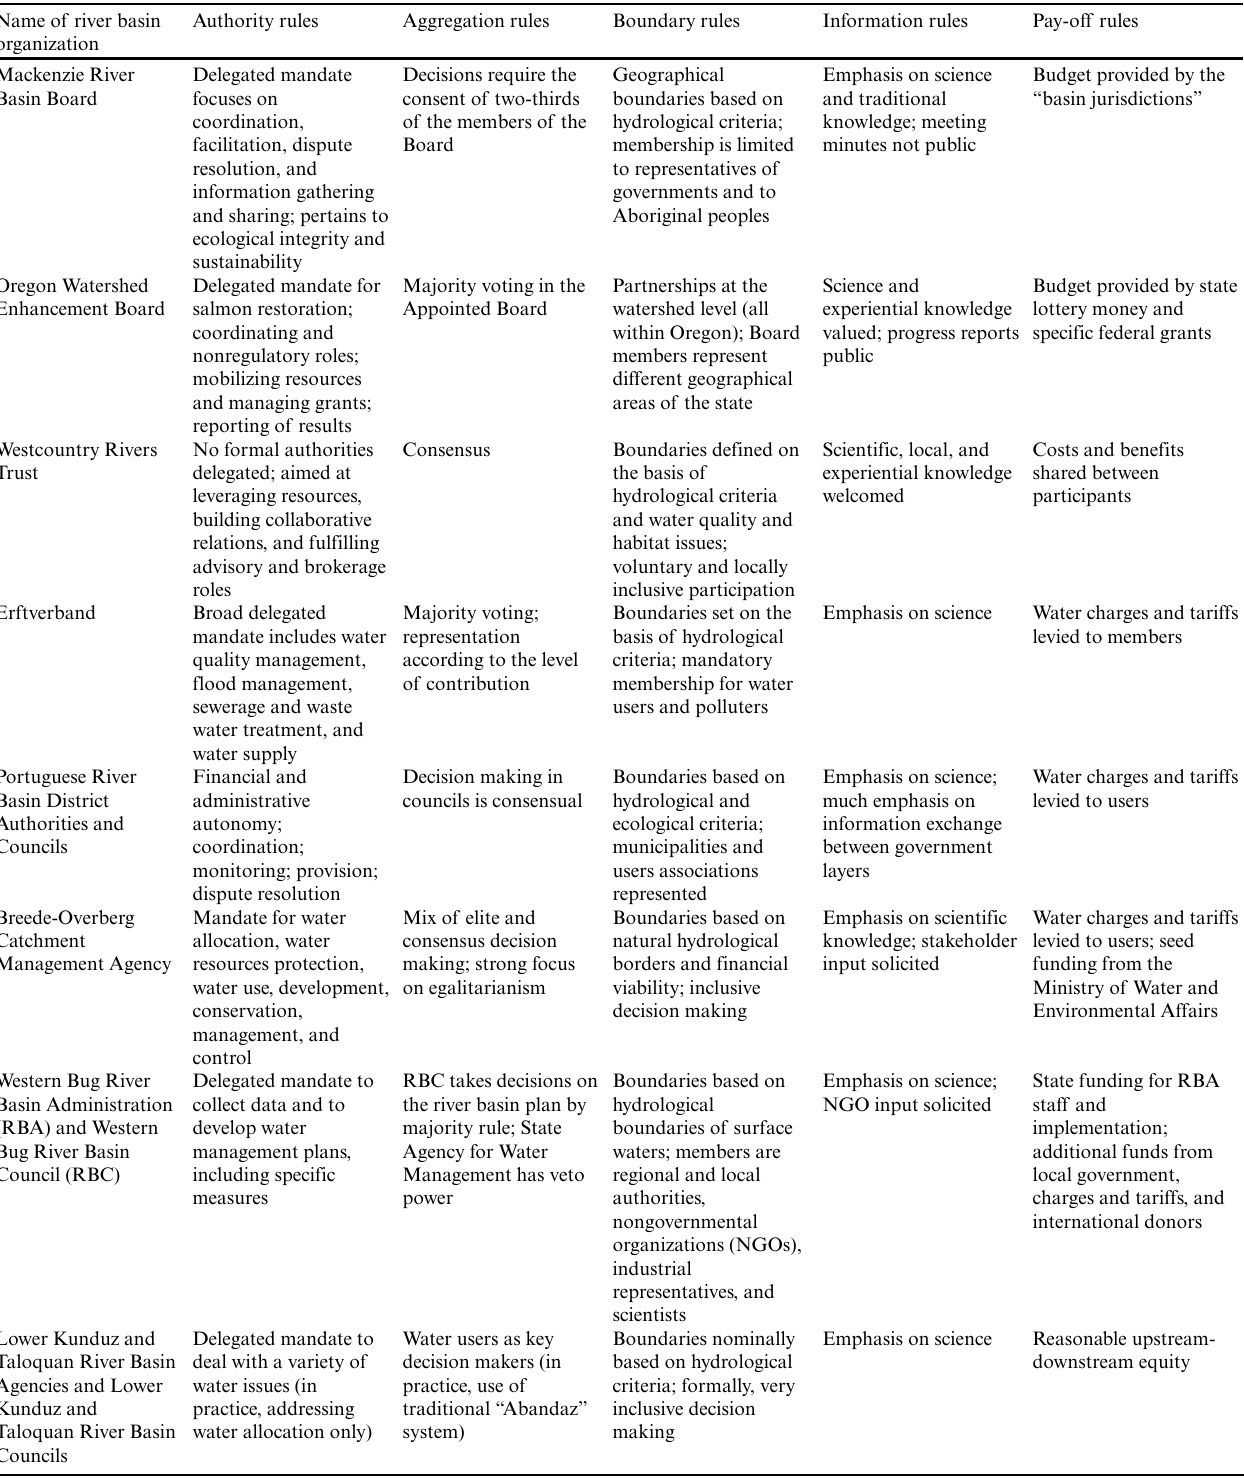
Table 2. Summary of authority, aggregation, boundary, information, and pay-off